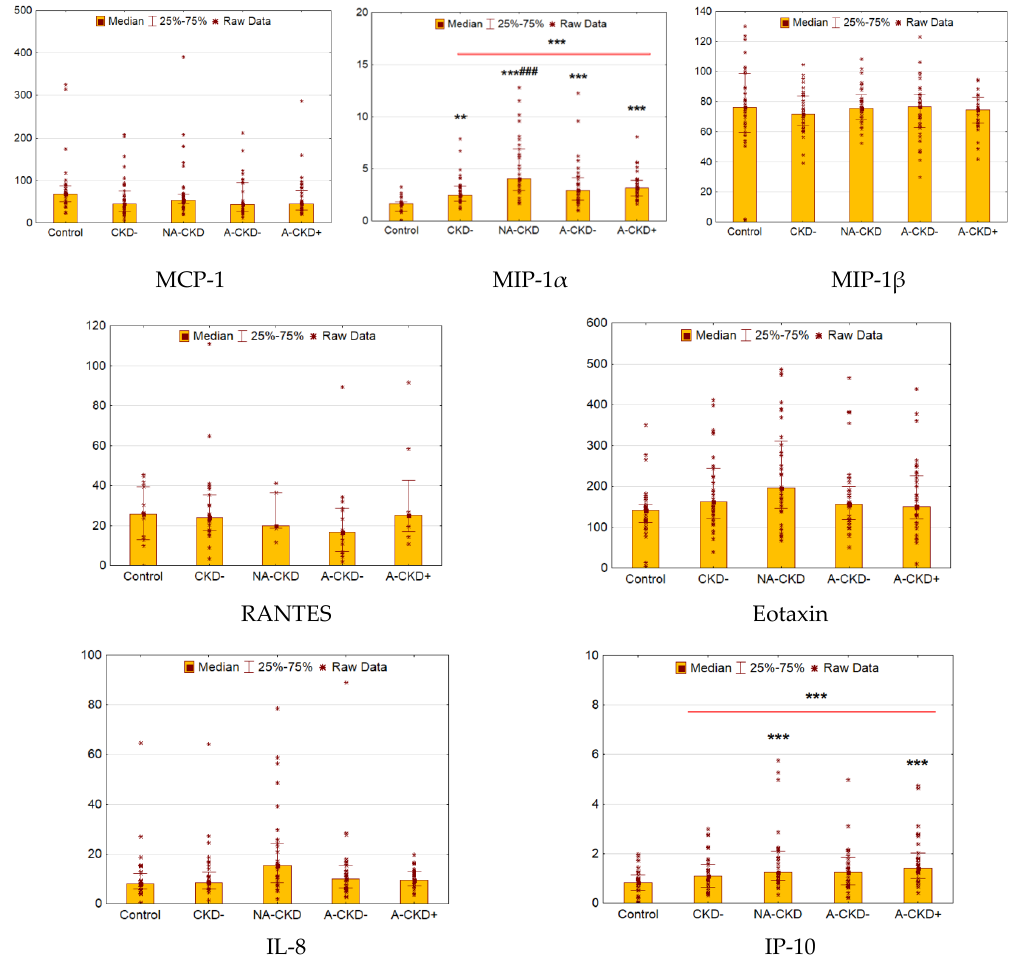
Figure 6. Serum concentrations of MCP-1 (CCL2), MIP-1 α (CCL3), MIP-1 β (CCL4), RANTES (CCL5) and eotaxin (CCL11/CCL24/CCL26) (ng/mL for RANTES and IP-10, pg/mL for others). CKD − : The group of individuals with estimated glomerular filtration rate(eGFR) ≥ 60 mL/min/1.73 m 2 and urinary albumin-to-creatinine ratio(UACR) <3.0 mg/mmol; NA-CKD: Non-albuminuric chronic kidney disease, the group of individuals with eGFR <60 mL/min/1.73 m 2 and UACR <3.0 mg/mmol; A-CKD − : Group of patients with eGFR ≥ 60 mL/min/1.73 m 2 and UACR ≥ 3.0 mg/mmol; A-CKD+: Group of individuals with eGFR <60 mL/min/1.73 m 2 and UACR ≥ 3.0 mg/mmol. ** p < 0.01, *** p < 0.001 vs. control, ### p < 0.001 vs. CKD − ; Mann–Whitney and Kruskal–Wallis test, Holm’s step-down procedure.